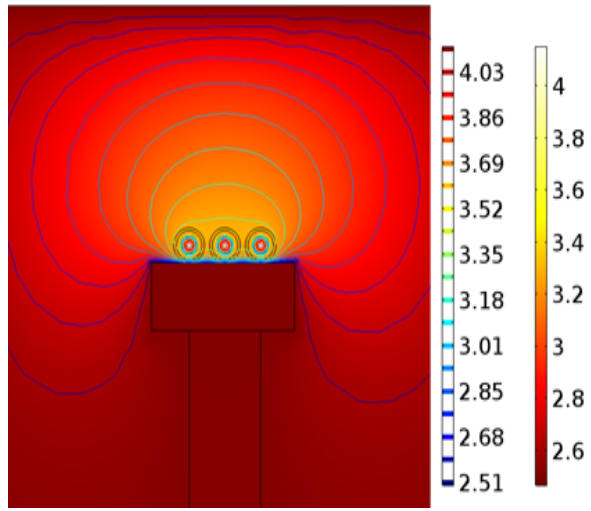
Figure 11. An example of the temperature distribution on the surface of a cable placed on a concrete structure for the maximum temperature difference on a logarithmic scale (log10